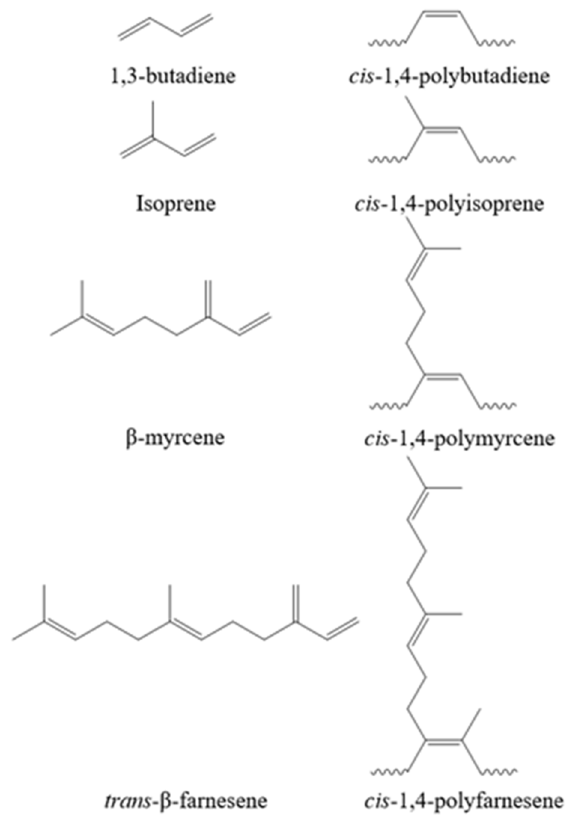
Figure 1. Chemical structure of monomers and the resultant high cis rubbers.